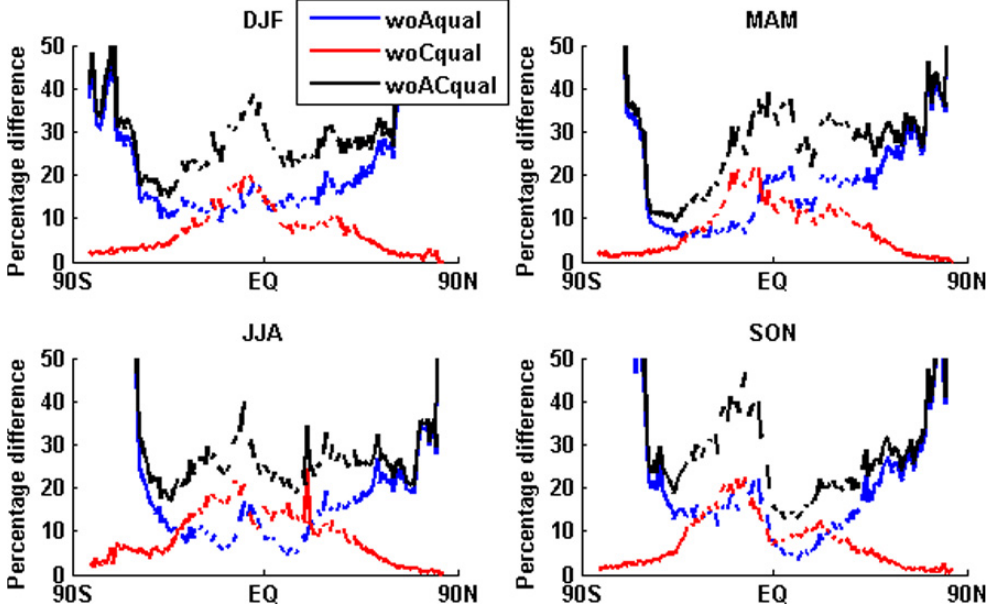
Fig. 5. The zonal mean percentage difference in overlap frequency when (a) the quality flag for the aerosol feature is switched off (denoted by woAqual), (b) the quality flag for the cloud feature is switched off (woCqual), and (c) the quality flags for both aerosol and cloud features are switched off (woACqual). Note that the percentage differences are with respect to the case when the strictest quality criteria were used.